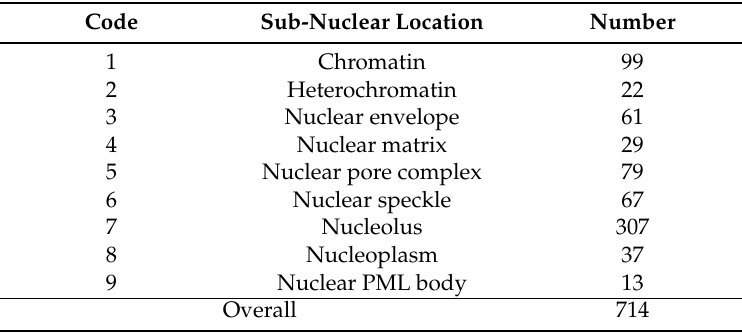
Table 2. Protein benchmark Dataset 1 of nine sub-nuclear locations.